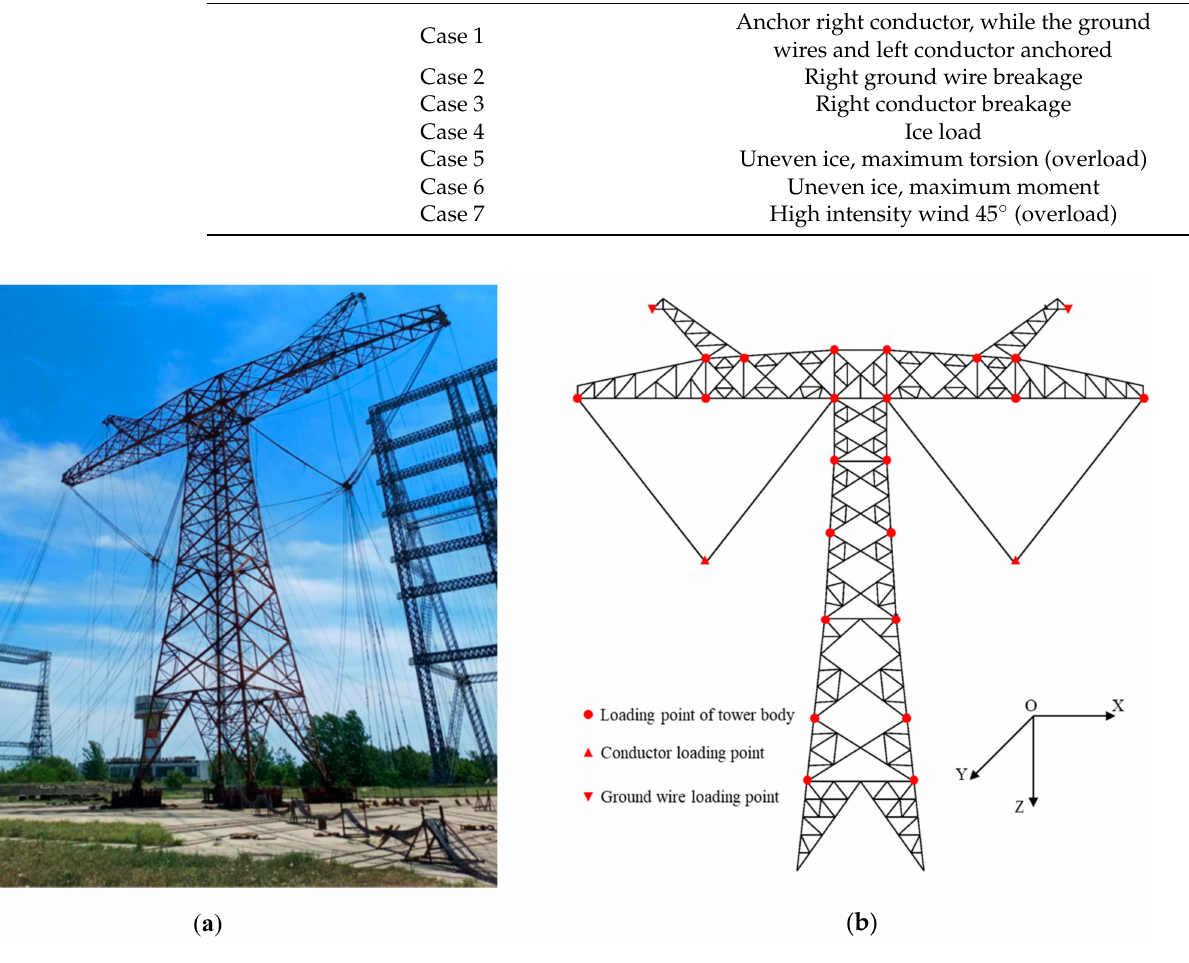
Figure 2. Schematic of experimental facilities and loading points. ( a ) Photo of the loading test; ( b ) Loading